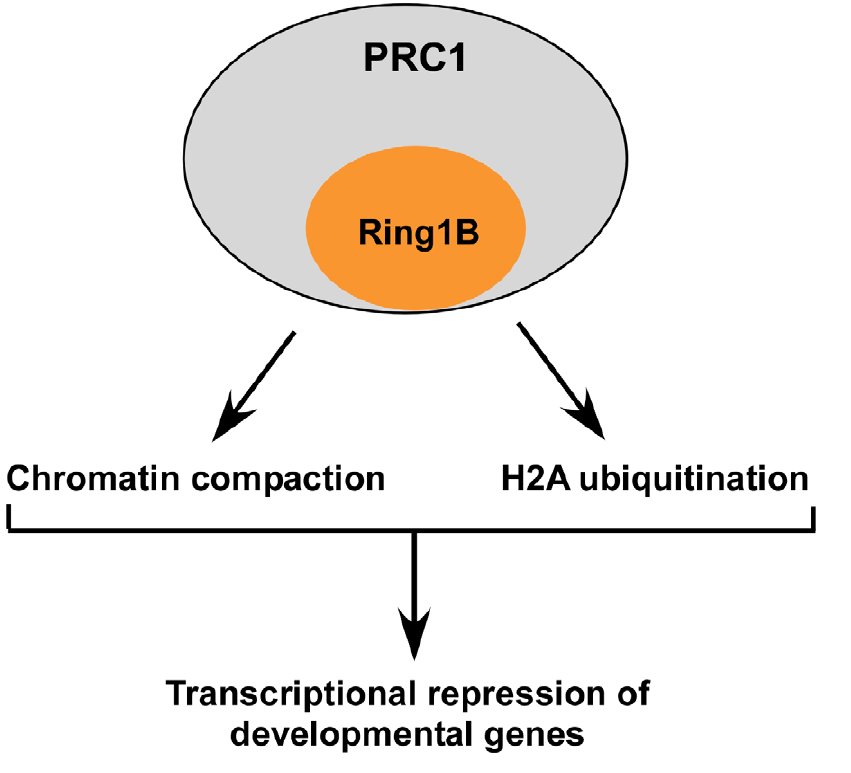
Figure 4. A schematic summary of this study demonstrating that PRC1-dependent repression of developmental genes in ES cells is mediated by multiple effector